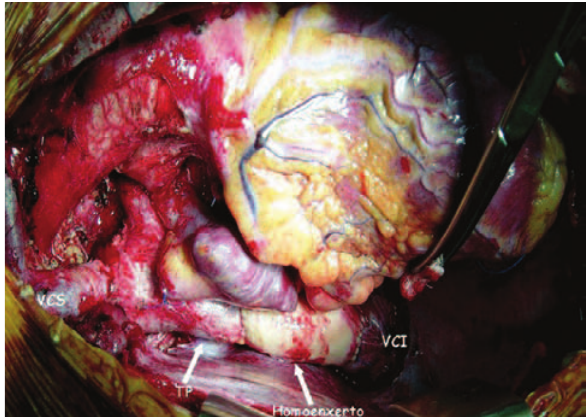
Fig. 3 - Homoenxerto criopreservado de aorta descendente como tubo extracardíaco conectando a veia cava inferior (VCI) ao tronco pulmonar (TP). A veia cava superior (VCS) anastomosada